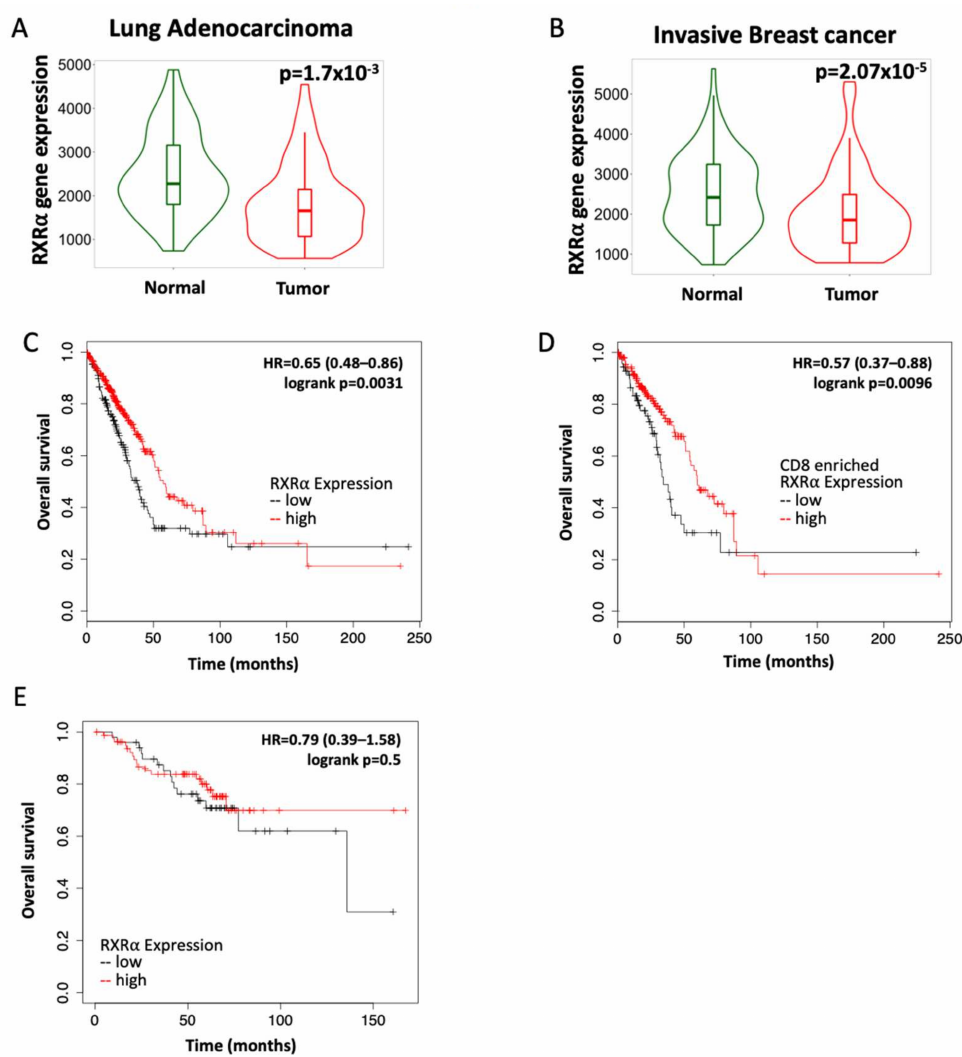
Figure 1. RXR expression correlates with overall survival in patients with lung adenocarcinoma and HER2-positive breast cancer. RXR α expression was evaluated by RNA sequencing in tumors and adjacent normal tissue from patients with ( A ) lung adenocarcinoma ( n = 57) or ( B ) invasive breast cancer ( n = 112). Prognostic value of high vs. low RXR α expression in patients with ( C ) lung adenocarcinoma ( n = 504; 330 high and 174 low); ( D ) lung adenocarcinomas enriched for CD8 T cells ( n = 273; 203 high and 72 low) and ( E ) HER2-positive breast cancer ( n = 129; 80 high and 49 low). Data for all plots were accessed and analyzed using